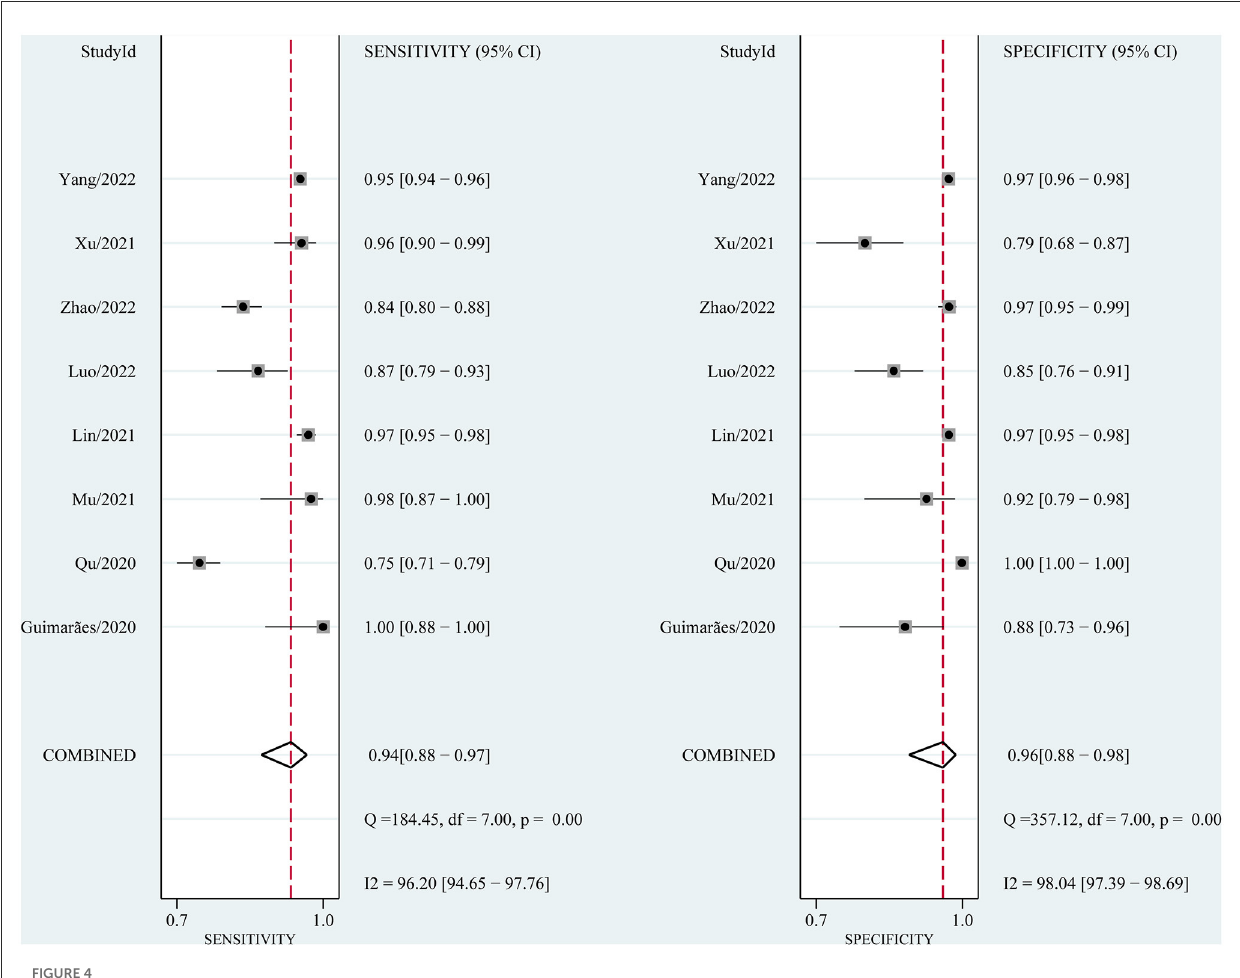
FIGURE4 Forest plot of sensitivity and specificity of AI in identifying CAG.